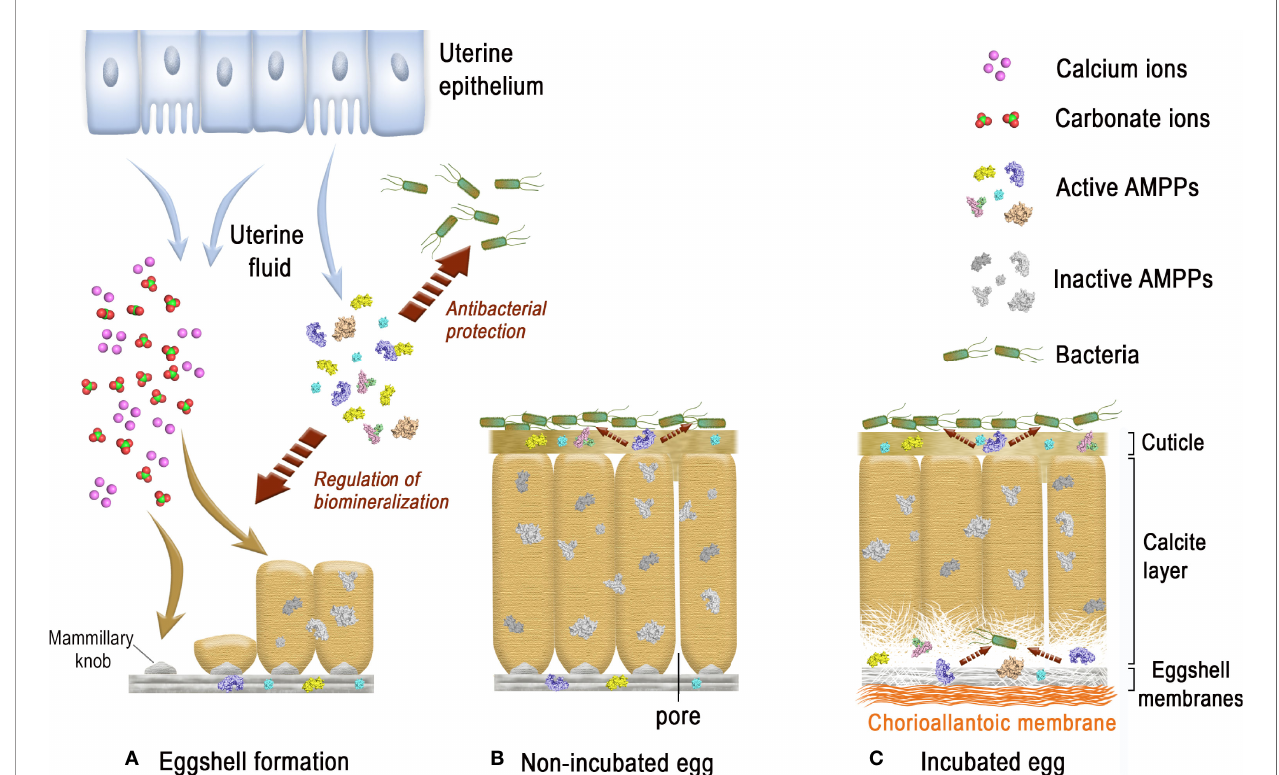
FIGURE 12 | Graphical representation of the innate immune functions of eggshell AMPPs in eggshell mineralization and antibacterial protection. (A) During the formation of the eggshell in the uterus, ions of the mineral phase (calcium, carbonate ions) and proteins (including AMPPs) are secreted by the uterine epithelial cells into the extracellular milieu (uterine fl uid). Some AMPPs can interact with ions and participate in the stabilization of ACC and/or regulate the growth of calcite crystals. These AMPPs become progressively embedded in the eggshell mineral during the mineralization process and are assumed to be inactive once immobilized. If bacterial contamination of the uterine fl uid occurs during eggshell formation, the presence of soluble AMPPs can provide an antimicrobial defense to keep the interior of the egg free from pathogens. (B) Once the egg is laid, the eggshell exterior is exposed to environmental bacterial species that colonize the egg cuticle surface. In contrast to AMPPs embedded in the calcite layer, surface-exposed cuticle AMPPs may directly interact with bacteria and modulate the eggshell microbiome. (C) During egg incubation, the embryo-derived chorioallantoic membrane progressively develops at the inner surface of the eggshell membranes and creates a local acidi fi cation that dissolves the mammillary layer mineral to release calcium and carbonate ions required for embryonic bone calci fi cation, and also to liberate the numerous mineral-associated proteins. Once solubilized, eggshell AMPPs are thought to recover their biological activity and locally reinforce innate immune protection to resist bacterial contamination following the penetration of pathogens through eggshell pores or microcracks. (Original artwork by TM, NG and